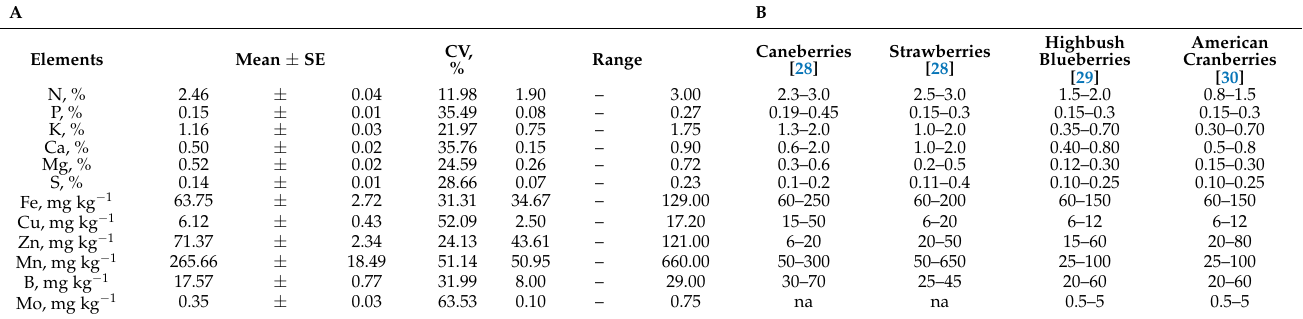
Table 4. ( A ) Nutrient concentration in air-dried cloudberry leaves in Latvia, 2020-2022; ( B ) sufficiency ranges for different berry